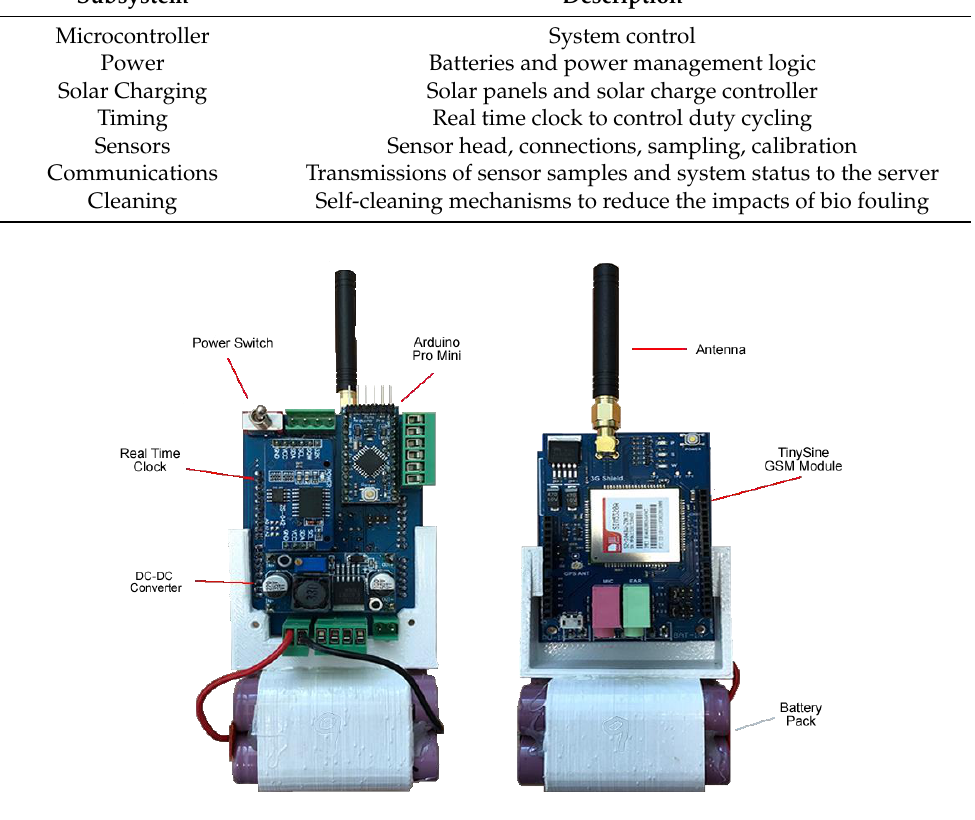
Figure 3. SEMAT Electronics.